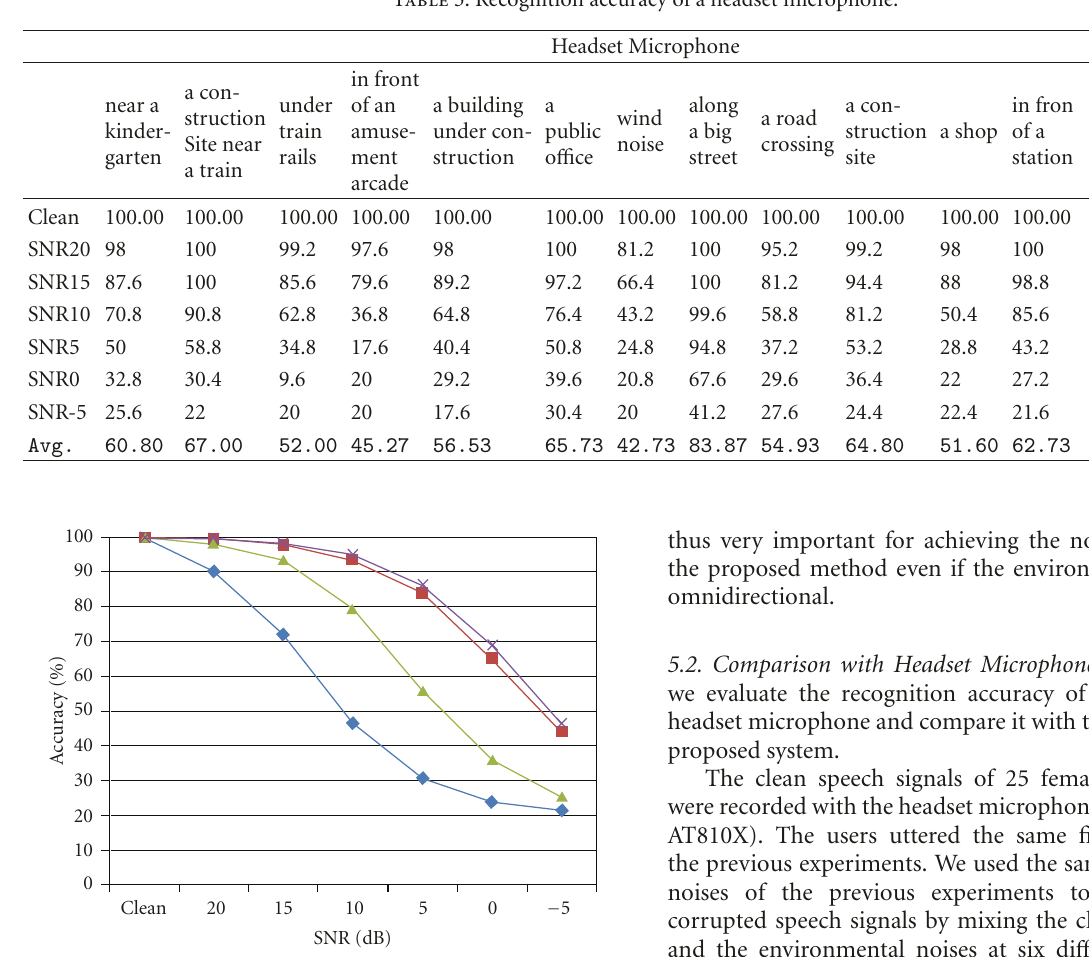
Table 5: Recognition accuracy of a headset microphone.